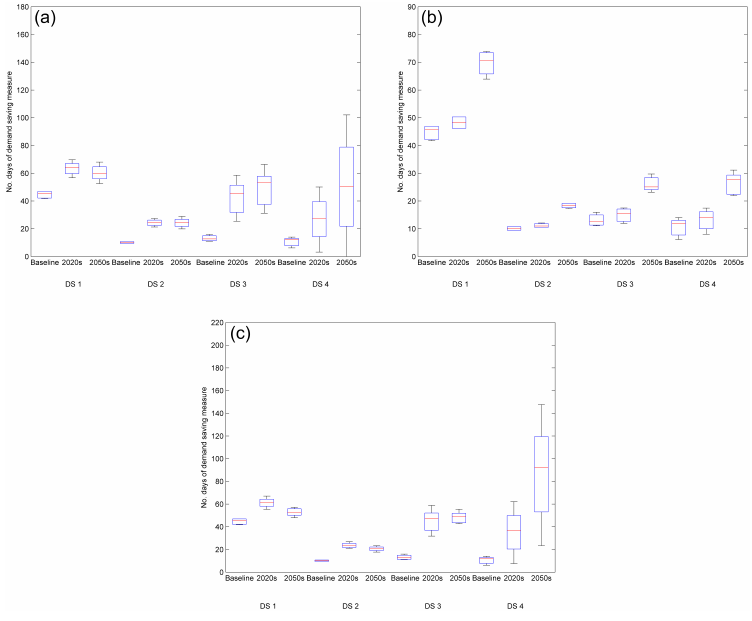
Figure 8. Number of demand saving days per 100 years (DS1–DS4) under BSL, SCN20, and SCN50 scenarios for (a) climate change projections only; (b) population growth projections only; (c) both climate and population projections, in all cases per capita demand remains constant at present-day value. Box plots indicate the median, 25th, and 75th percentile values; whiskers show the 10th and 90th percentile